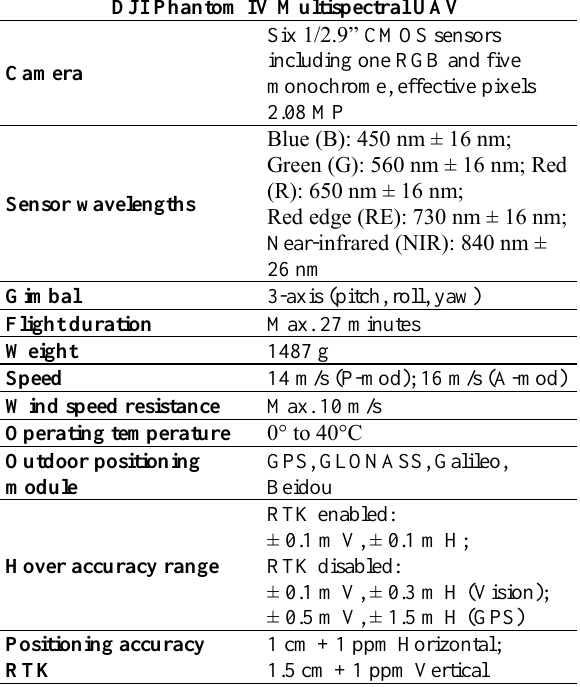
Table 1. Specifications of DJI Phantom IV Multispectral UAV MAPIR Camera Reflectance Calibration Ground Target Package (V2) contains four colours as black, dark grey, light grey and white. Table 2 lists the used reflectance values of the spectral bands in four colours of the MAPIR panel separately. Figure 1. GTU Campus (a), Study area (b)